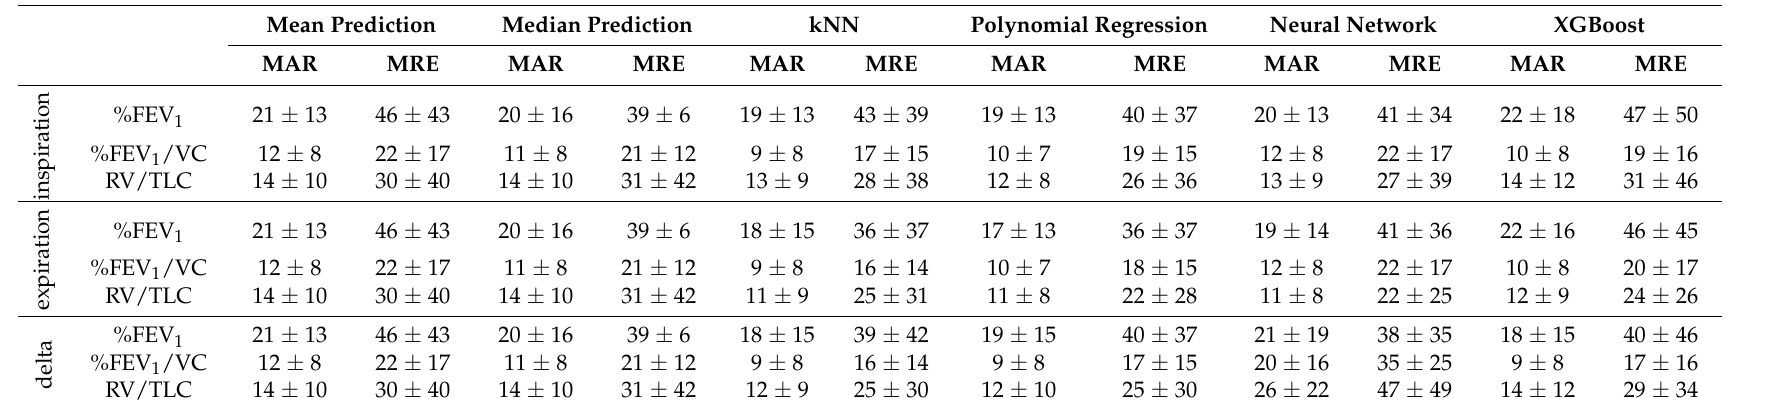
Mean absolute error (MAR) and the mean relative error (MRE) of the predicted lung function values. The MAR is given as the amount of the absolute error needed to compensate the negative signs. FEV1: forced expiratory volume in one second; VC: vital capacity; RV: residual volume; TLC: total lung capacity; kNN: k- nearest neighbour; MRE: mean relative error; MAR: mean absolute